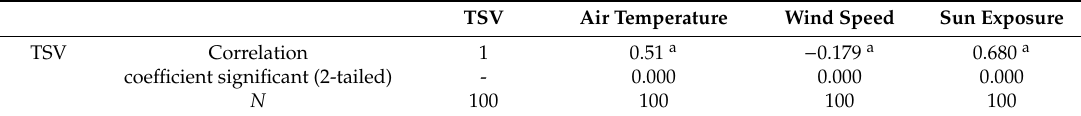
Table 3. Correlation analysis of thermal response